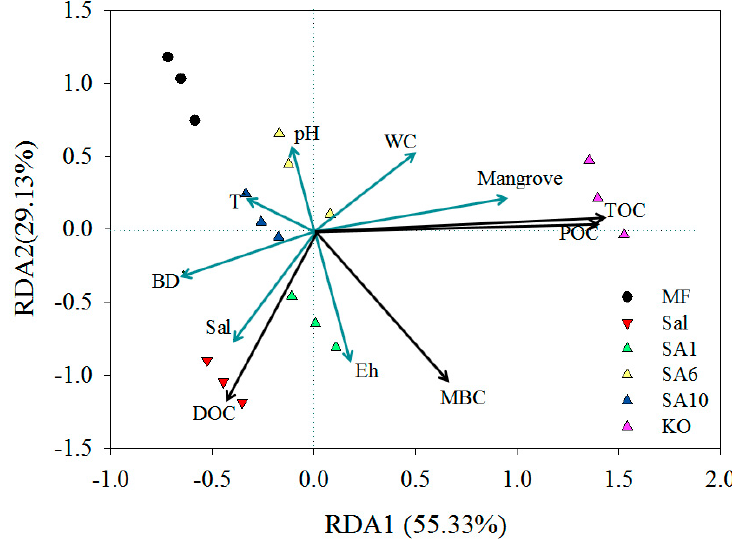
Figure 4. Redundancy Analysis (RDA) ordination showing the relationship between carbon contents of top 10 cm and environmental parameters of surface 0–10 cm soil (Sal means S. alterniflora age, Mangrove means mangrove age).